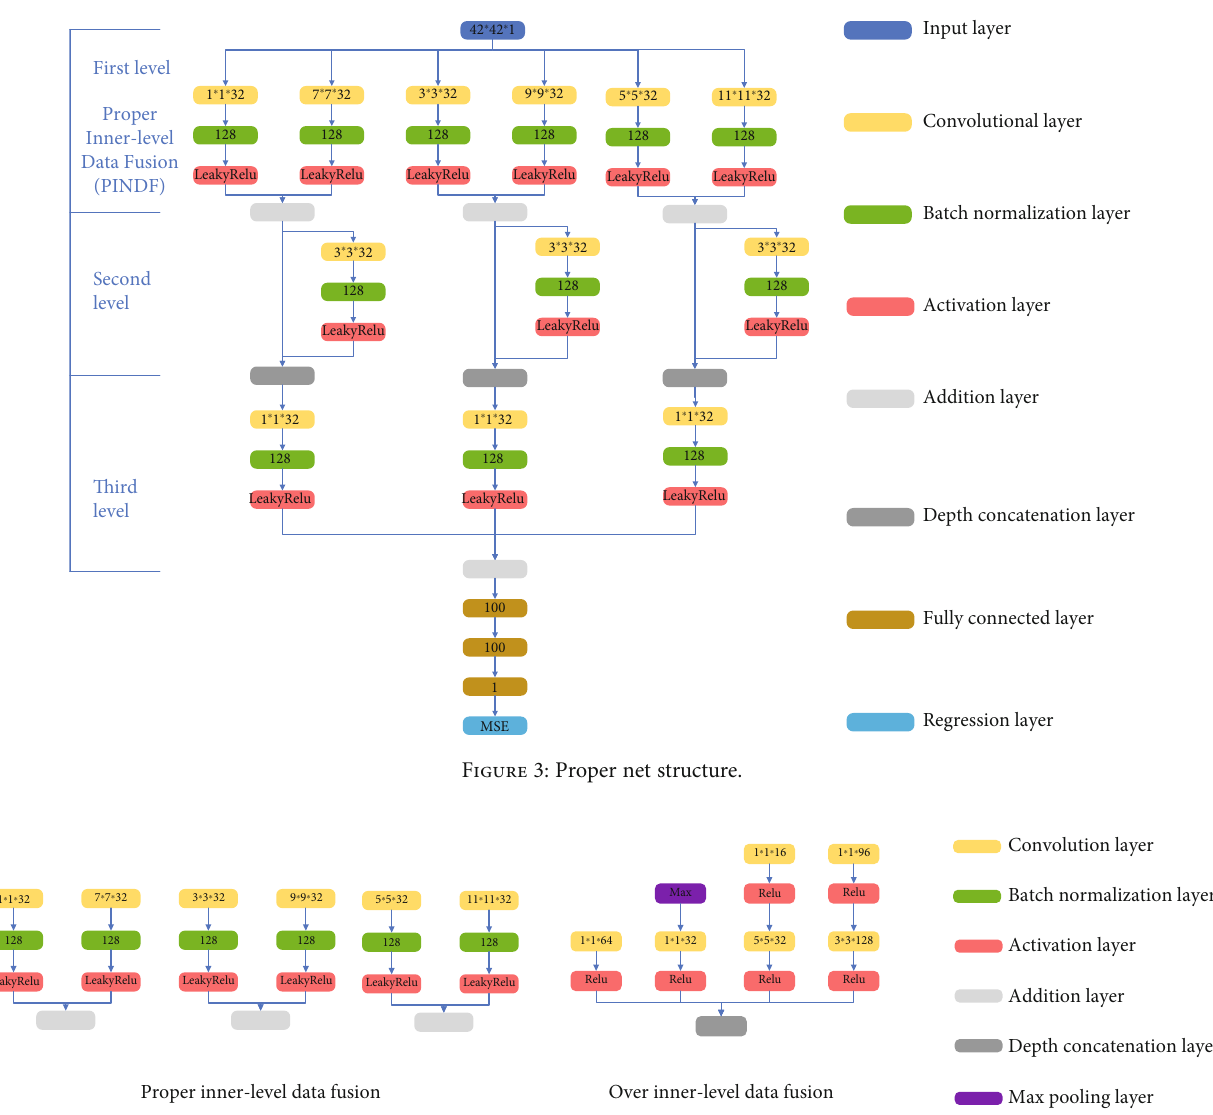
Figure 4: Comparison between Proper inner-level data fusion structure (PINDF) and over inner-level data fusion structure (OINDF). Table 2: Training